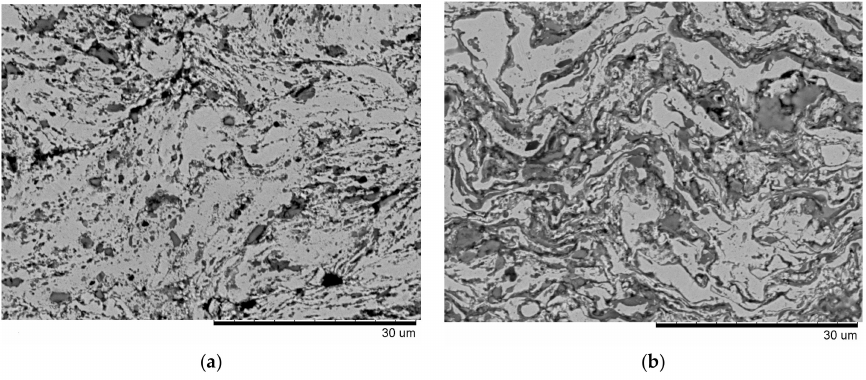
Figure 8. Microstructure of the coatings produced by detonation spraying of 20 vol. % Ti 3 SiC 2 -Cu feedstock powders, explosive charge 30%: ( a ) k = 1.1 and ( b ) k = 2.5